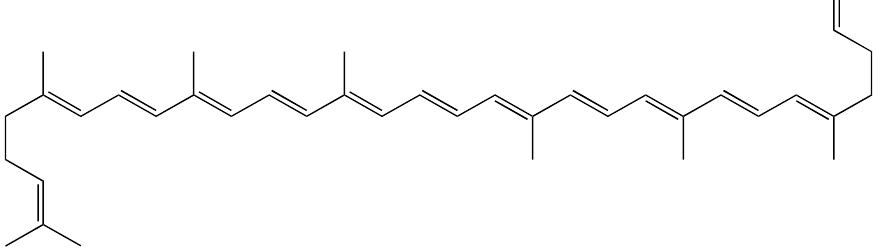
Figure 10. Structure of lycopene, the major constituent of S. lycopersicum . The antiplatelet effects of different concentrations (4, 6, 8, 10 and 12 µ M) of lycopene were examined in human PRP stimulated by 2.5 µ M ADP and 1 µ g/mL collagen (Table 4). All tested concentrations of lycopene displayed significant inhibitory effects in ADP- and collagen-induced platelets. However, when compared to aspirin (140 µ M), inhibitory effects of lycopene were insignificant, as aspirin reduced aggregation by 47.79% ± 15.99% and 70.37% ± 7.49% upon stimulation with ADP and collagen, respectively. In addition, the synergistic inhibitory effects of lycopene and aspirin combinations were investigated but they were not significant